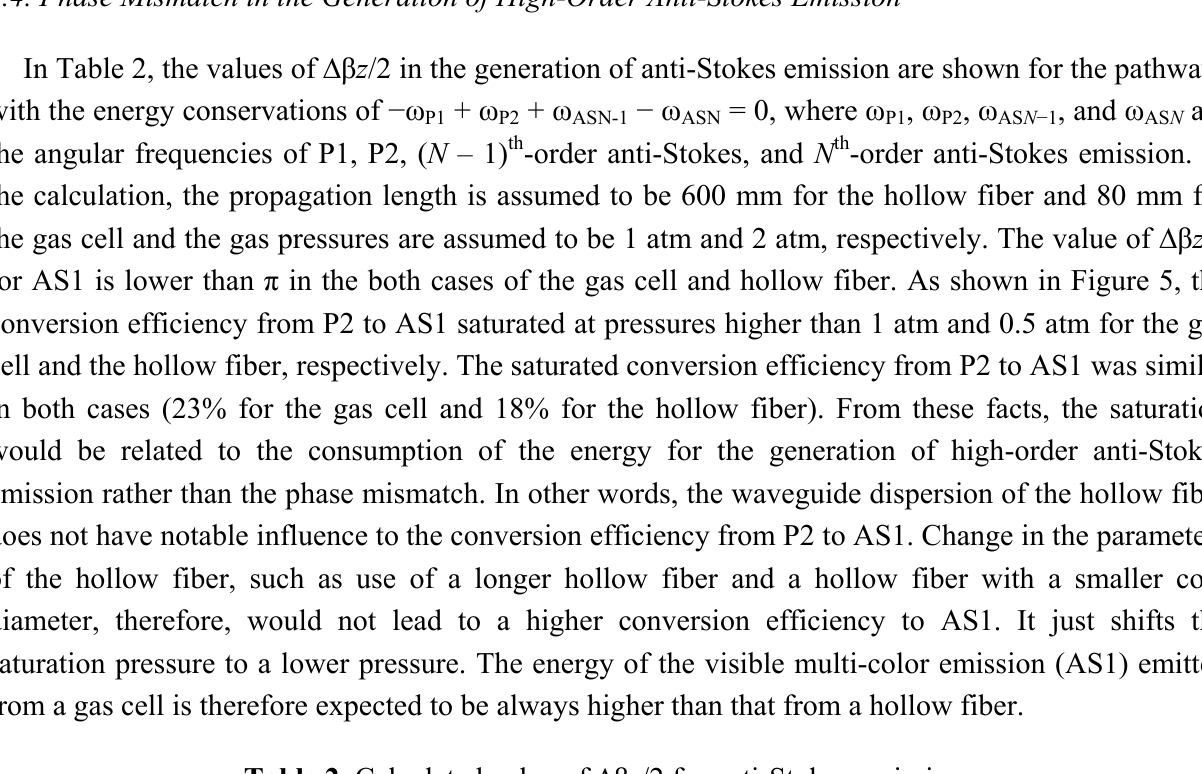
Table 2. Calculated value of ∆β z /2 for anti-Stokes